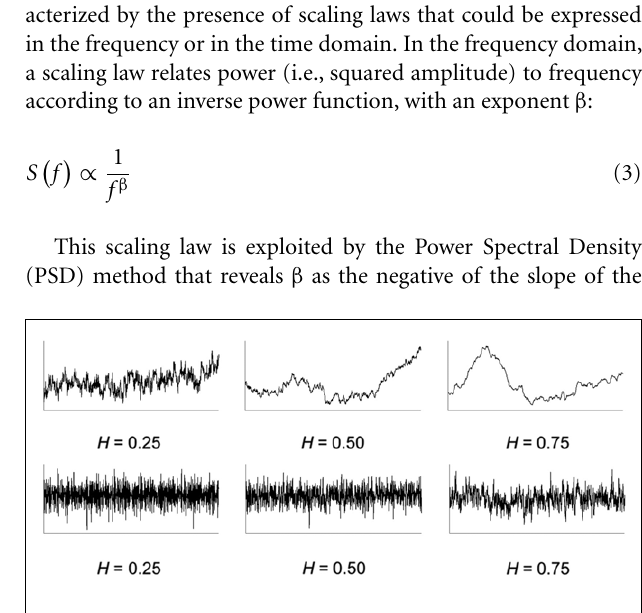
FIGURE 1 |Top row: example series of fractional Brownian motions (fBm) for three typical values of the scaling exponent. The central graph represents an ordinary Brownian motion ( H = 0.5).The left graph shows an anti-persistent fBm ( H = 0.25) and the right graph a persistent fBm ( H = 0.75).The corresponding fractional Gaussian noises series (fGn) are displayed in the bottom